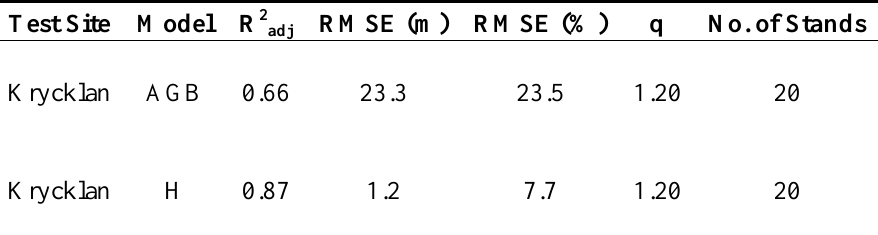
Table 11. Results for the 20 flatter stands at Krycklan using field reference data from the BioSAR 2008 campaign.